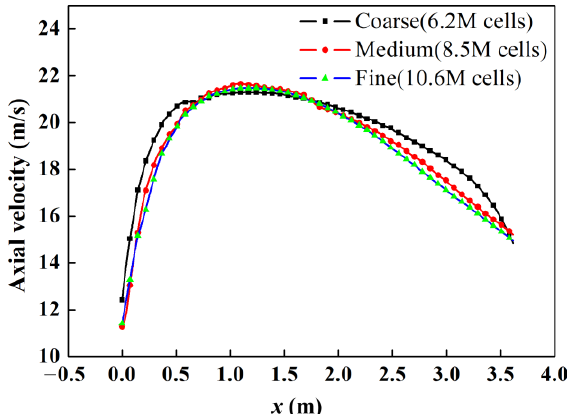
Figure 4. Axial velocity profiles for different grids.